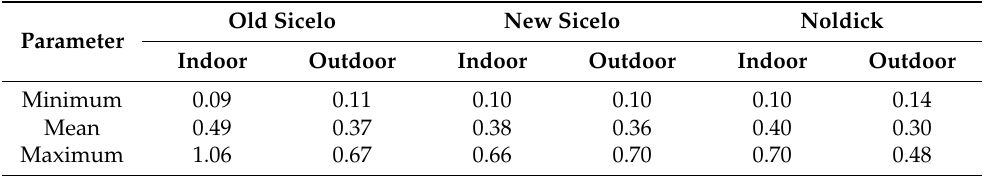
Table 3. Indoor and outdoor particle diameter ( µ m) measurements in the three residential areas. Old Sicelo Parameter